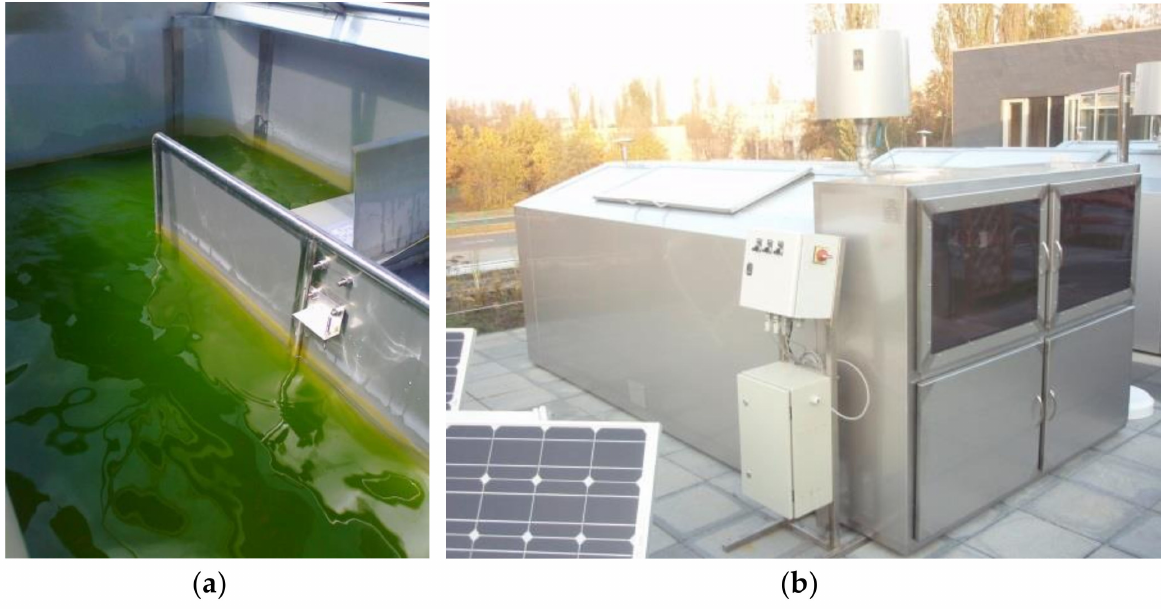
Figure 1. Photobioreactor for the cultivation of microalgae biomass used as feedstock in anaerobic digestion: ( a ) microalgae biomass; ( b ) general view of the